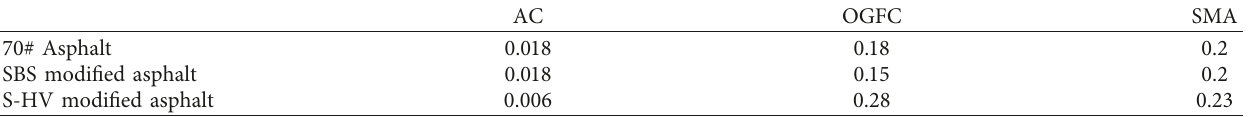
Table 8: Values of parameter A.